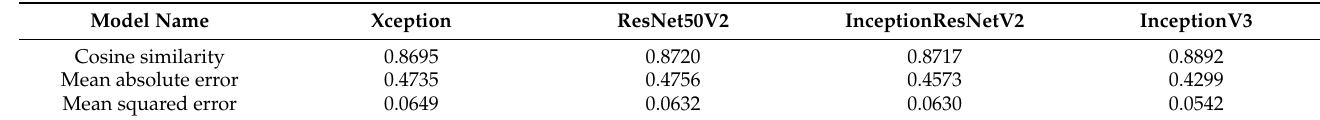
Table 11. Comparison of accuracy measures for the four best models after the fourth stage of the NN